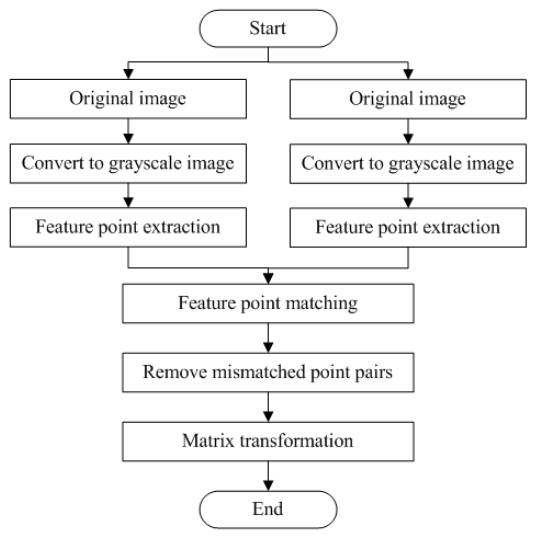
Figure 1. Procedure of feature-point-based image registration algorithm.